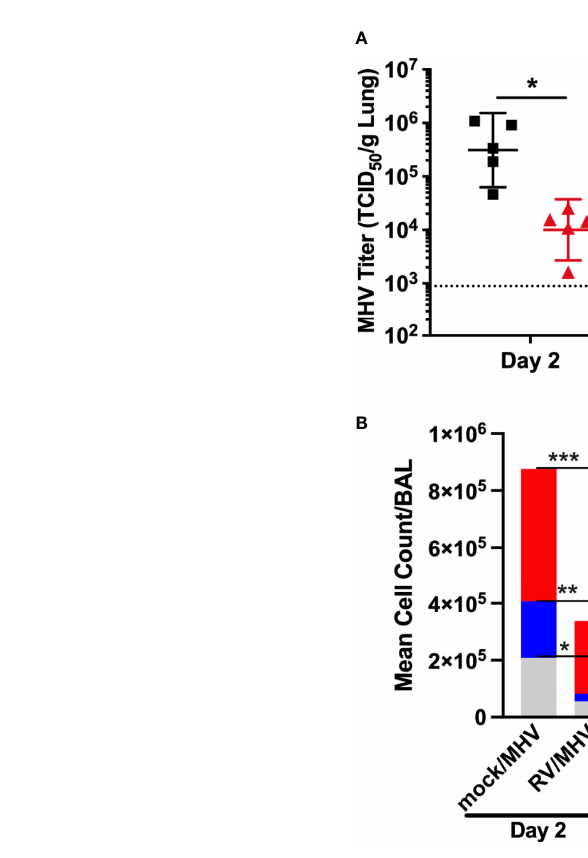
FIGURE 2 | Priming with RV limits MHV-1 replication in the lungs and recruitment of leukocytes to airways. Mice (n=5 per group and time point) were inoculated intranasally with RV (7.6x10 6 TCID 50 ) or saline (mock) on day -2, and MHV-1 (2x10 5 PFU) on day 0. (A) Lungs were collected, homogenized, and viral titers were determined by TCID 50 assay using17Cl.1 cells. (B) Cells were counted and collected from bronchoalveolar lavage (BAL) fl uid and stained with Wright-Giemsa stain for differential analysis. *p<0.05, **p<0.01,